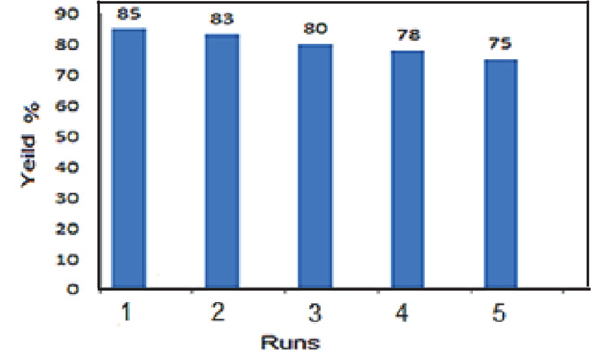
Figure 6. Reusability of the MnFe 2 O 4 nanoparticles as catalyst.